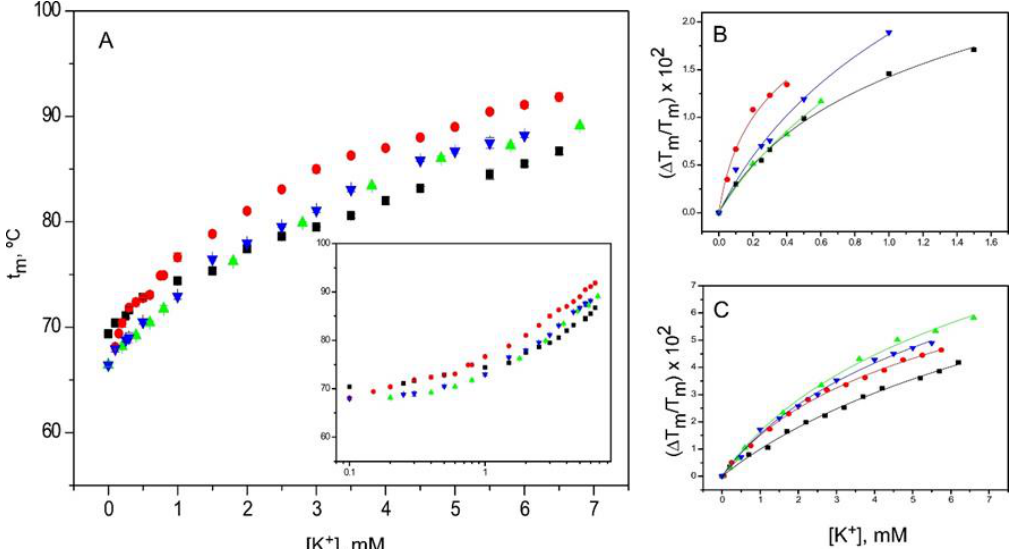
Figure 6. Effects of TBA + blockade on the binding of K + to KcsA. Panel A shows titration experiments conducted on KcsA samples as in Figure 5, but in the continuous presence of 10 mM TBA + . The results are the average ( n = 3) t m (in Celsius) ± SD. The symbols and colors are the same as in Figure 2. Inset to panel A is a semi-log plot that still reveals the presence of two sets of K + binding sites, even under TBA + blockade. Panels B and C show the fitting of the experimental data from the low and high K + concentration ranges, respectively, to Equation (1). The apparent K D values derived from such fittings are included in Table 1.